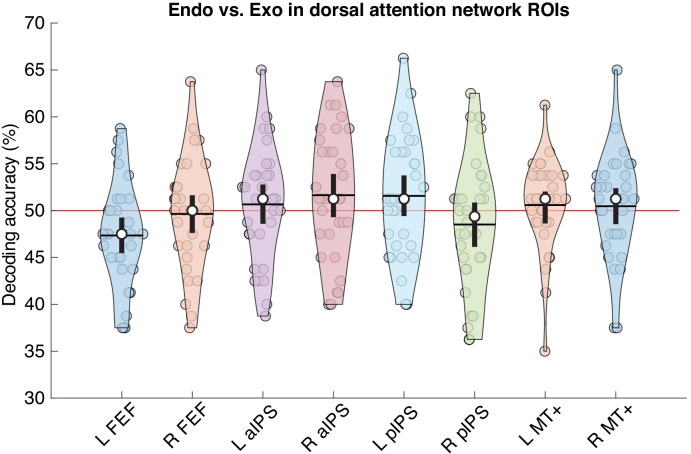
Decoding attention type in the dorsal attention network.The TPJ is part of the ventral attention network, which has been implicated in exogenous attention. Could it be the case that participants simulate attention orienting when reading the stories, leading to the above-chance endogenous-versus-exogenous decoding in the TPJ? If this is the case, one should expect above-chance decoding also in areas of the dorsal attention network, which has been implicated in endogenous attention. To test this hypothesis, we replicated the endogenous-versus-exogenous analysis in four areas (bilaterally) typically considered to constitute the dorsal attention network: the frontal eye fields (FEF), the anterior and posterior intraparietal sulcus (aIPS and pIPS), and the middle temporal complex (MT+). The ROIs were defined as 10-mm-radius spheres around the peak coordinates (reported in Fox et al., 2006): left FEF (MNI: −25,–16, 61), right FEF (MNI: 27,–14, 58), left aIPS (MNI: −42,–44, 46), right aIPS (MNI: 34,–51, 49), left pIPS (MNI: −22,–72, 51), right pIPS (MNI: 19,–72, 57), left MT+ (MNI: −47,–68, −14), and right MT+ (MNI: 51,–63, −14). The results showed that none of the dorsal attention network ROIs decoded the attention type in the stories better than chance (all ps > 0.05, based on permutation testing with 10,000 iterations, uncorrected for multiple comparisons). Violin plots show mean (black horizontal line) and median (white circle) decoding accuracy (%), 95% confidence interval around the mean based on bootstrap distribution (black vertical line), a kernel density estimation (shaded area), and individual data points. The red horizontal line indicates chance decoding.